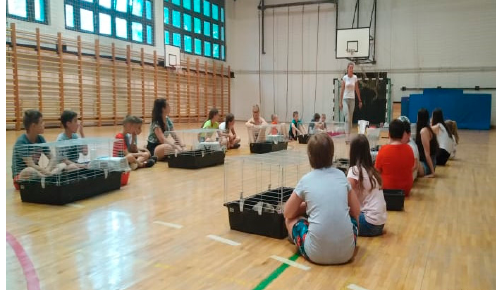
Figure 1. Children Approach Test—session 1, rabbits’ emplacement